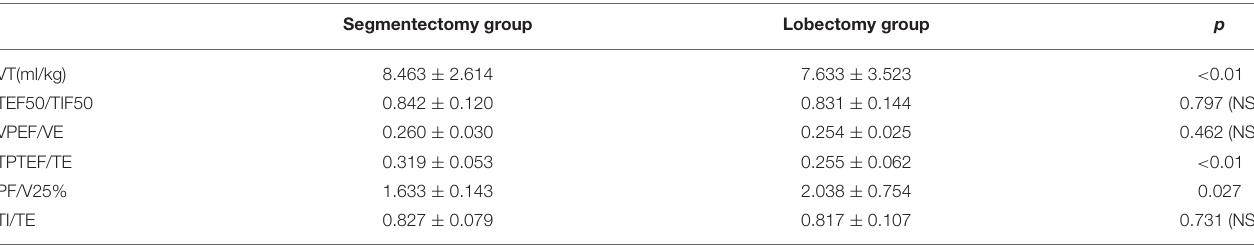
TABLE 2 | Pulmonary function test results (1 month after surgery).